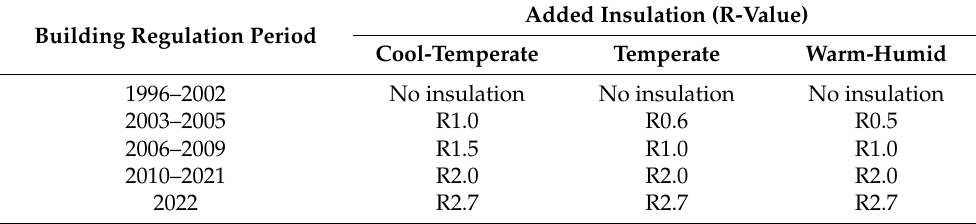
Figure 6. Sectional details of the clay masonry veneer wall in the NCC climate zone 6. The changes in the insulation requirements, denoted as R values, of the timber-framed clay masonry veneer wall type are shown in Table 3. These insulation requirements were used for the building material selection and arrangement and for hygrothermal modelling. Table 3. Regulatory insulation requirements for clay masonry veneer wall from 1996 to 2022 [1,89,90,94,95].